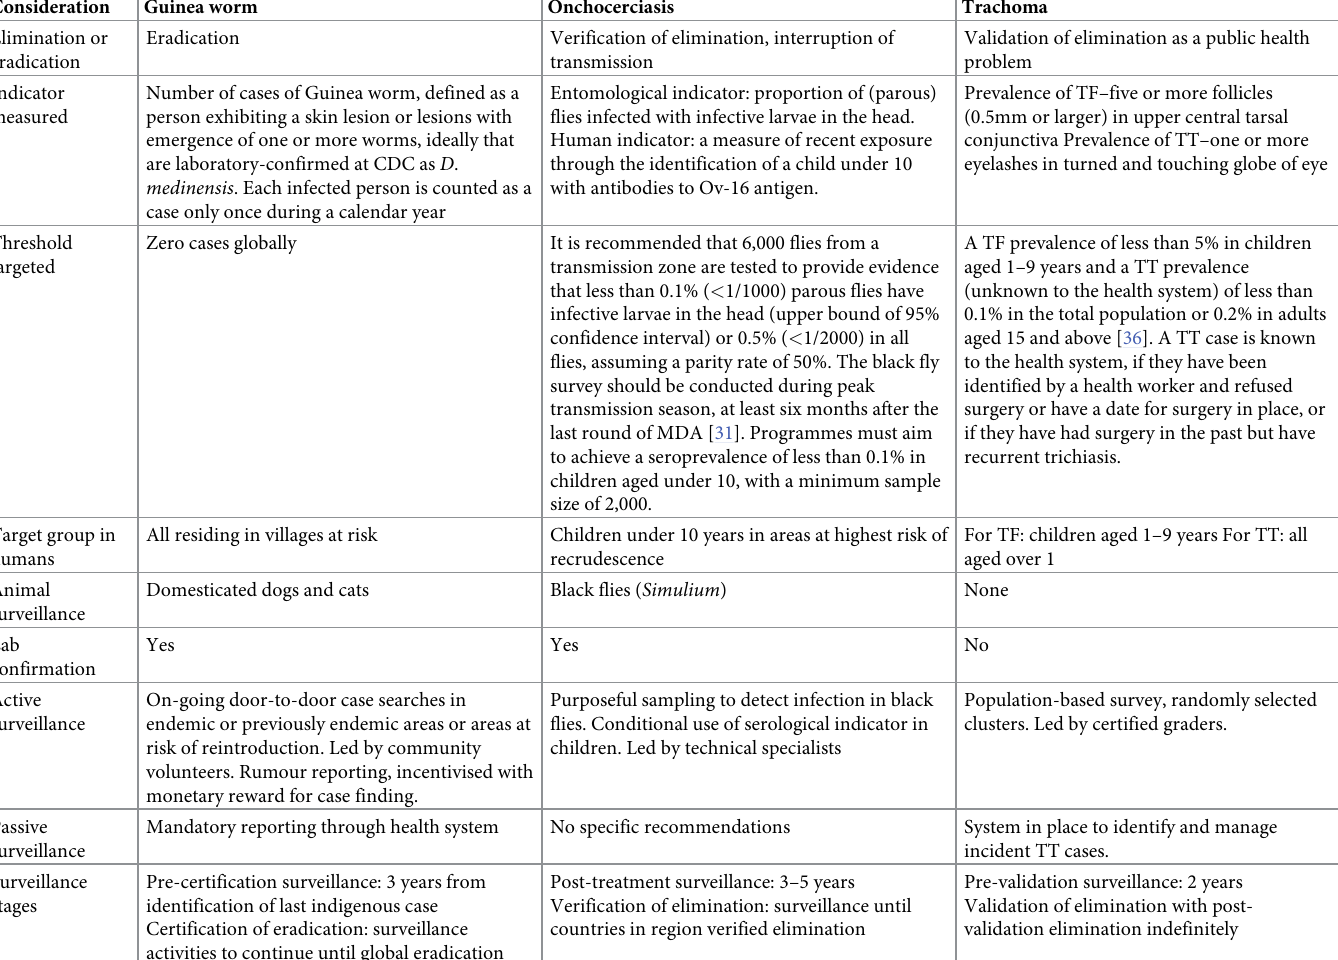
Table 2. Recommendations on surveillance for eradication of guinea worm and elimination of onchocerciasis and